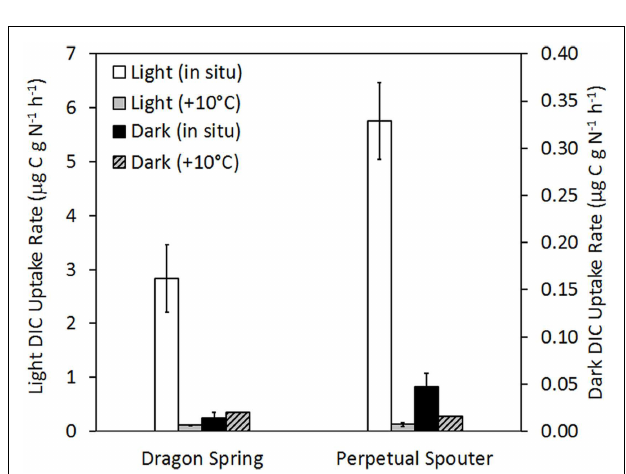
FIGURE 5 | Rate of DIC uptake in phototrophic assemblages sampled from near ( < 1cm) the photosynthetic fringe at Nymph Creek (fringe pH = 2.89,Temp. = 52.1˚C, total sulfide ≤ 150nM) as a function of increasing amendment of sodium sulfide to final concentrations of 5 and 20 µ M when incubated under light and dark conditions (A). Rate of DIC uptake in photosynthetic assemblages sampled from near ( < 1cm) the photosynthetic fringe at Dragon Spring (fringe pH = 2.60,